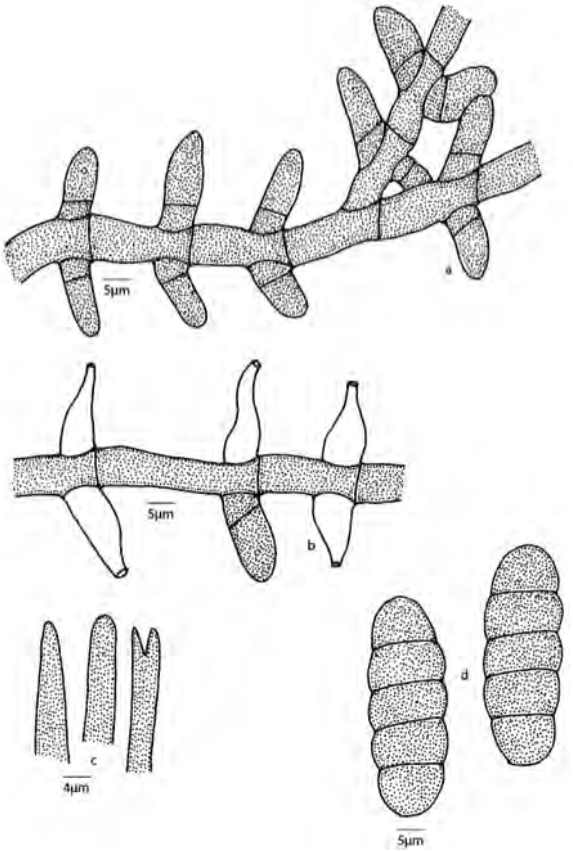
Figure 59. Meliola capensis var. malayensis a - Appressorium; b - Phialide; c - Apical portion of mycelial setae; d -